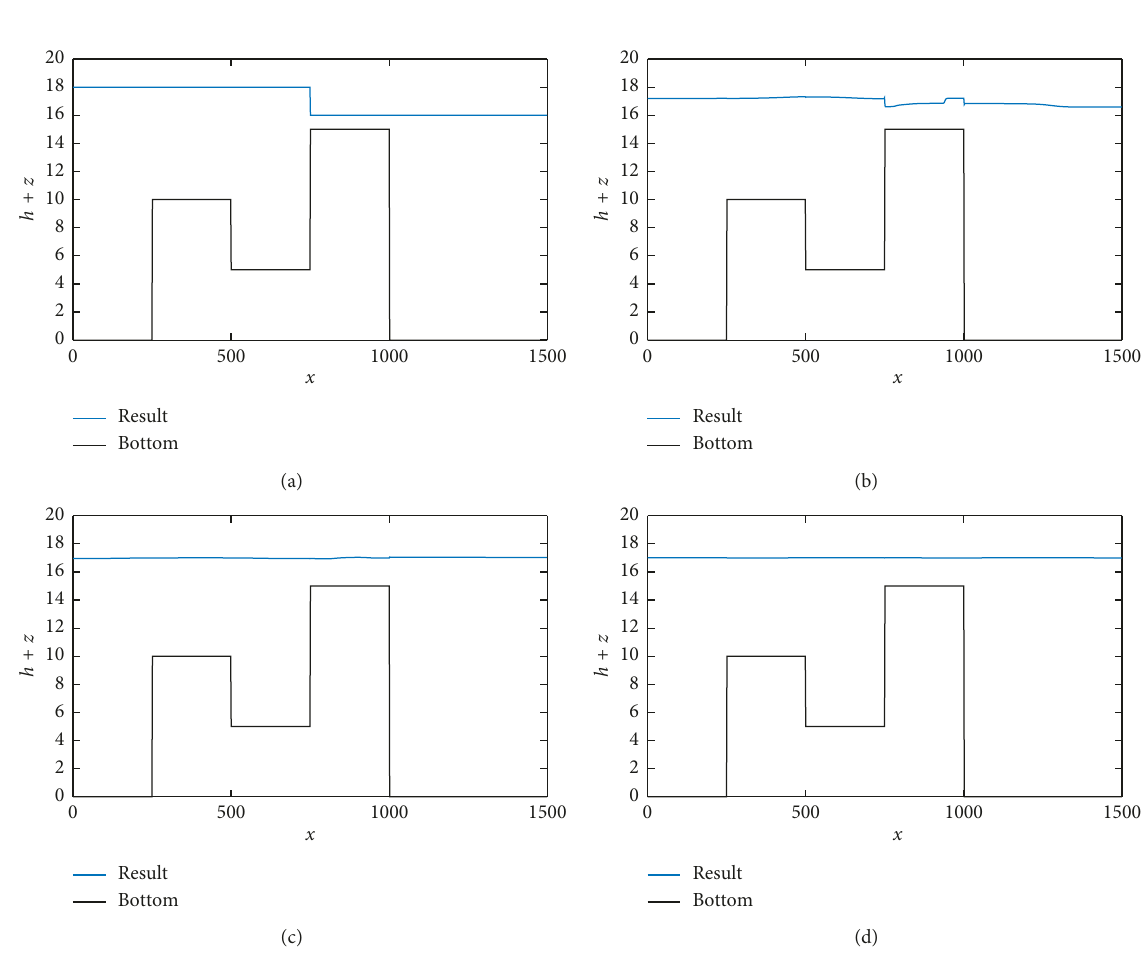
Figure 3: Numerical results at time 0 s (a), 150s (b), 400s (c), and 1000s (d).